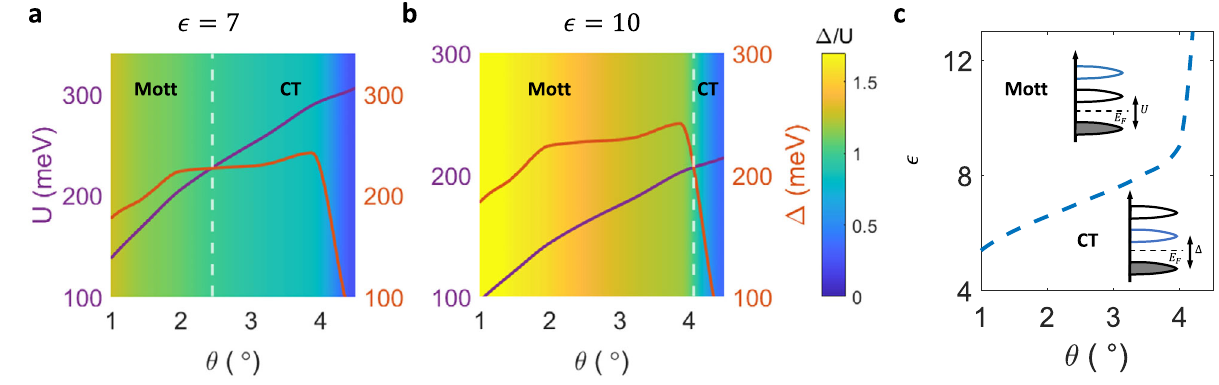
Fig. 4 Phase diagram of the half- fi lled heterobilayer. Characteristic energies of U and Δ at half- fi lling over different twist angles for a ϵ = 7, b ϵ = 10. The purple line is for U , and the red line is for Δ . The background represents the ratio Δ / U . The white dashed line represents the crossing between U and Δ , which is the critical point of the transition between Mott (to the left of the dashed line) and charge-transfer (CT) insulators (to the right of the dashed line). c Phase diagram of Mott and charge-transfer (CT) insulators at half- fi lling under different twist angles and dielectric